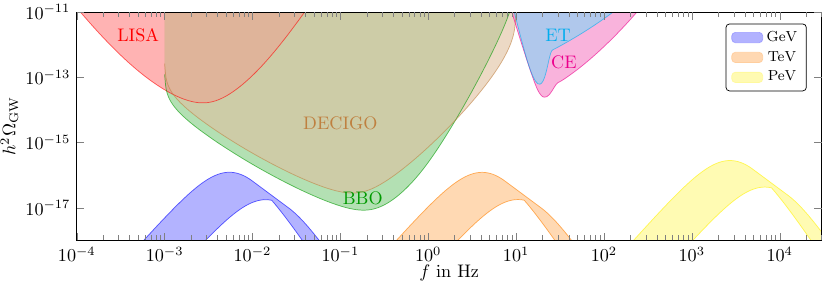
Figure 2. GW spectrum from the SU(6) confinement phase transition without quarks for the confine- ment scales T c = 1GeV, 1TeV, and 1PeV, compared to the power-law integrated sensitivity curves of di ff erent GW detectors. Figure taken from